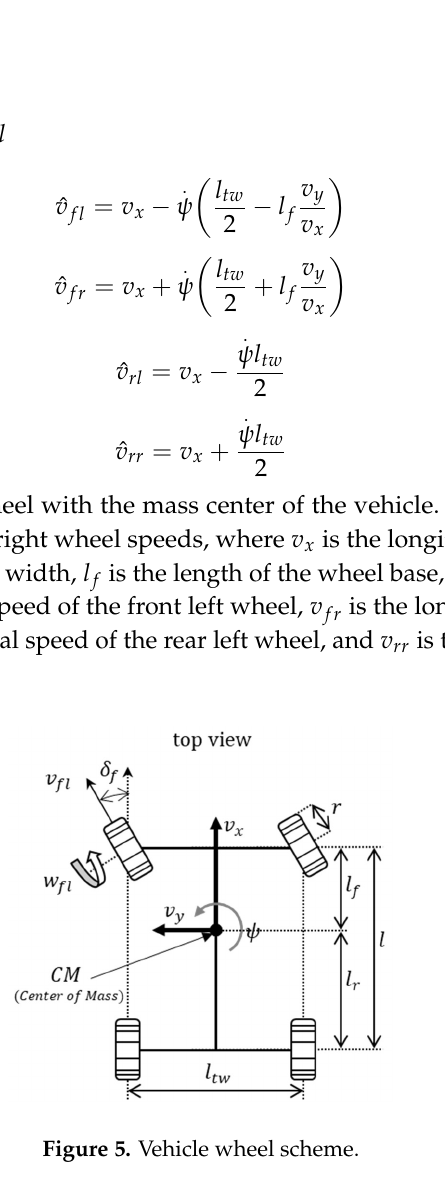
Figure 5. Vehicle wheel scheme.